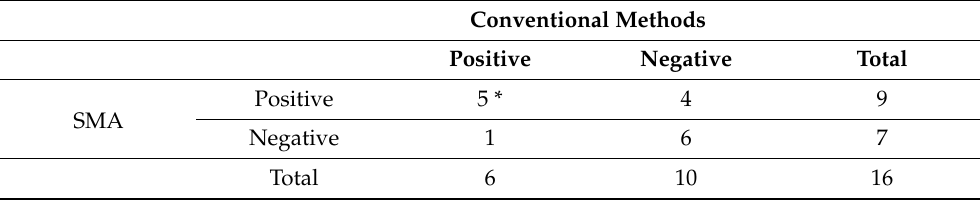
Table 3. Comparison of shotgun metagenomic testing with conventional methods for ocular